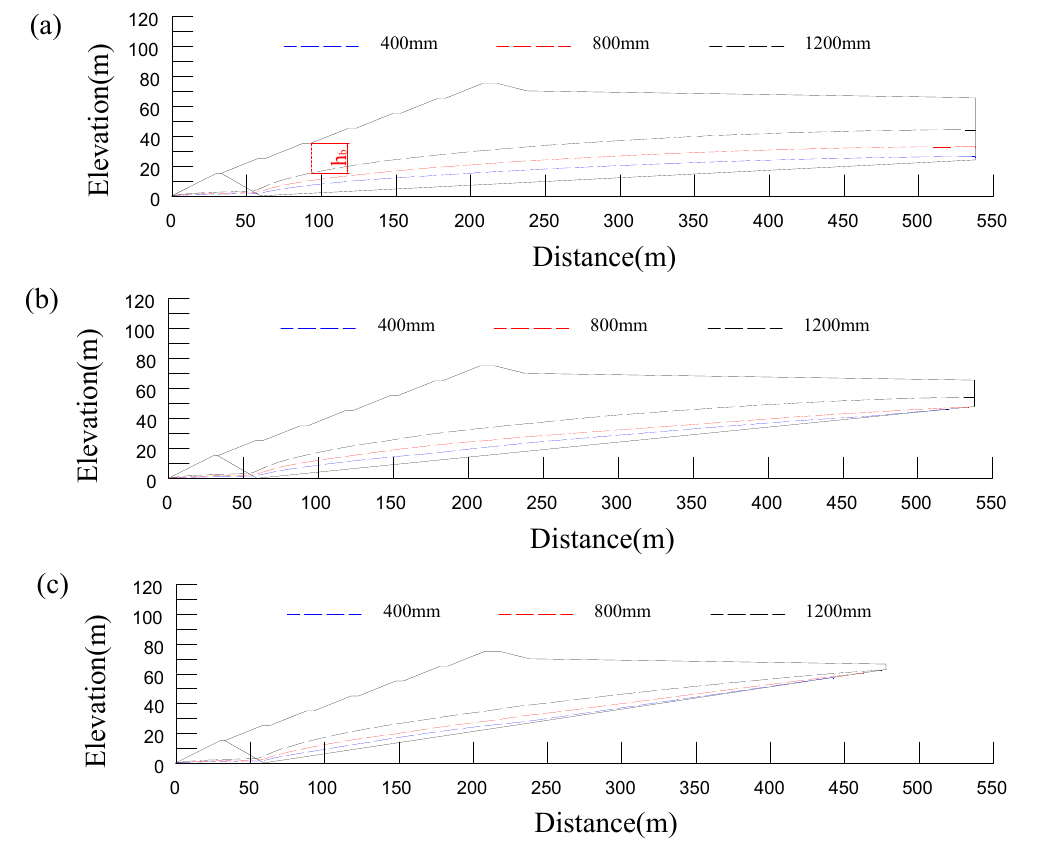
Figure 13. Rainfall deducting evaporation in 2020.